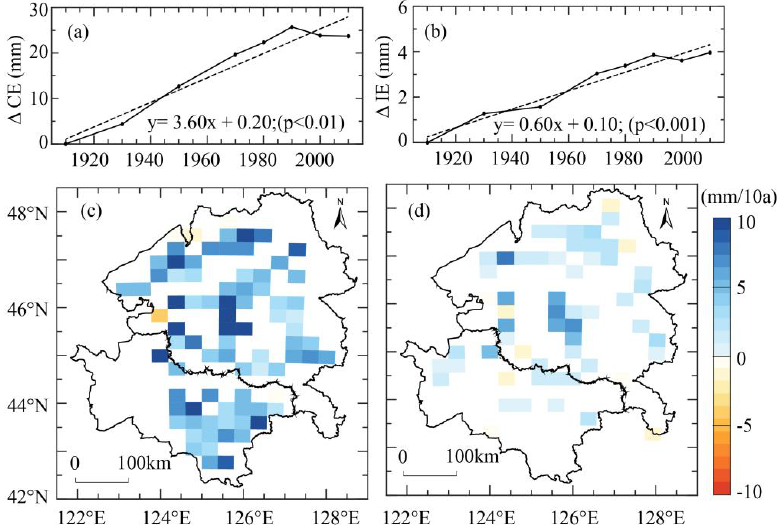
Figure 7. Trends of the plain-wide and grid-level deviations (against the 1910s) of the WRF-simulated canopy transpiration ( a , c ) and interception evaporation ( b , d ) in growing season. In ( a , b ), the dashed lines are the linear correlation lines. In ( c , d ), only grids with significant trends are colored.